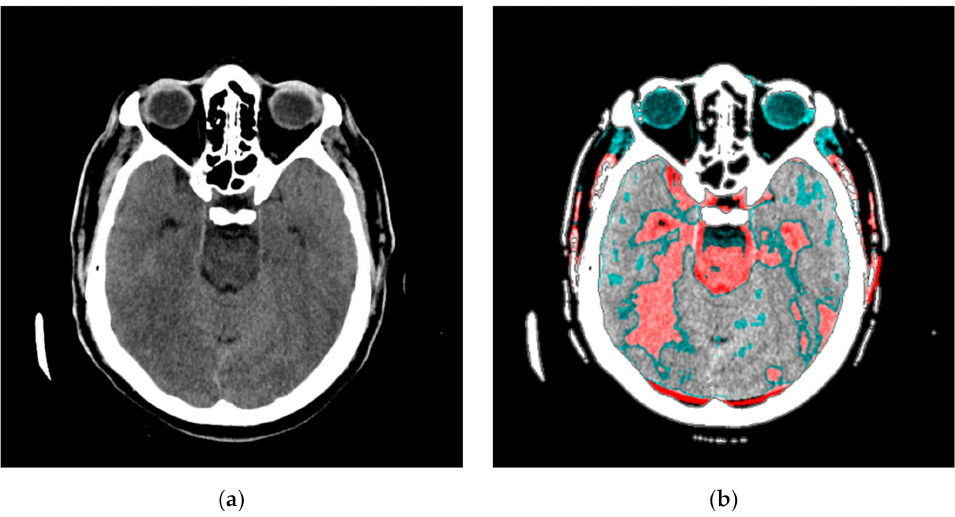
Figure A2. An image in gray levels with the averaged red part from processing. ( a ) An image display in gray levels and ( b ) an image display with the red, averaged part